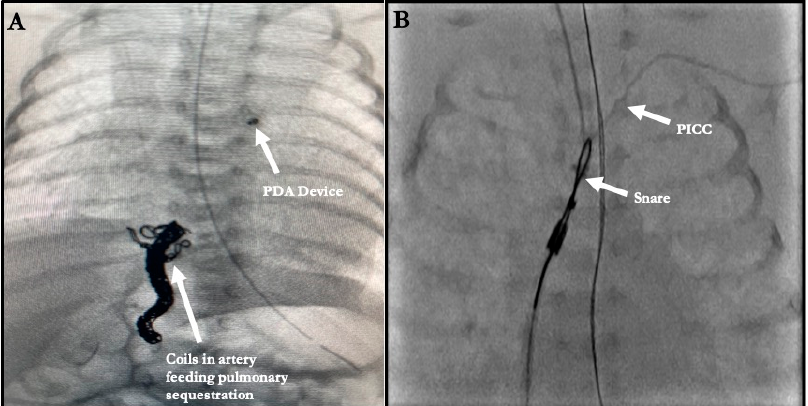
Figure 1. Angiograms of a Pulmonary Valvuloplasty in a 900-gram Infant. ( A ) Angiogram showing a dysplastic, thickened pulmonary valve. ( B ) Balloon angioplasty of the pulmonary valve with an obvious “waist.” ( C ) Post-balloon angioplasty angiogram of the pulmonary valve.